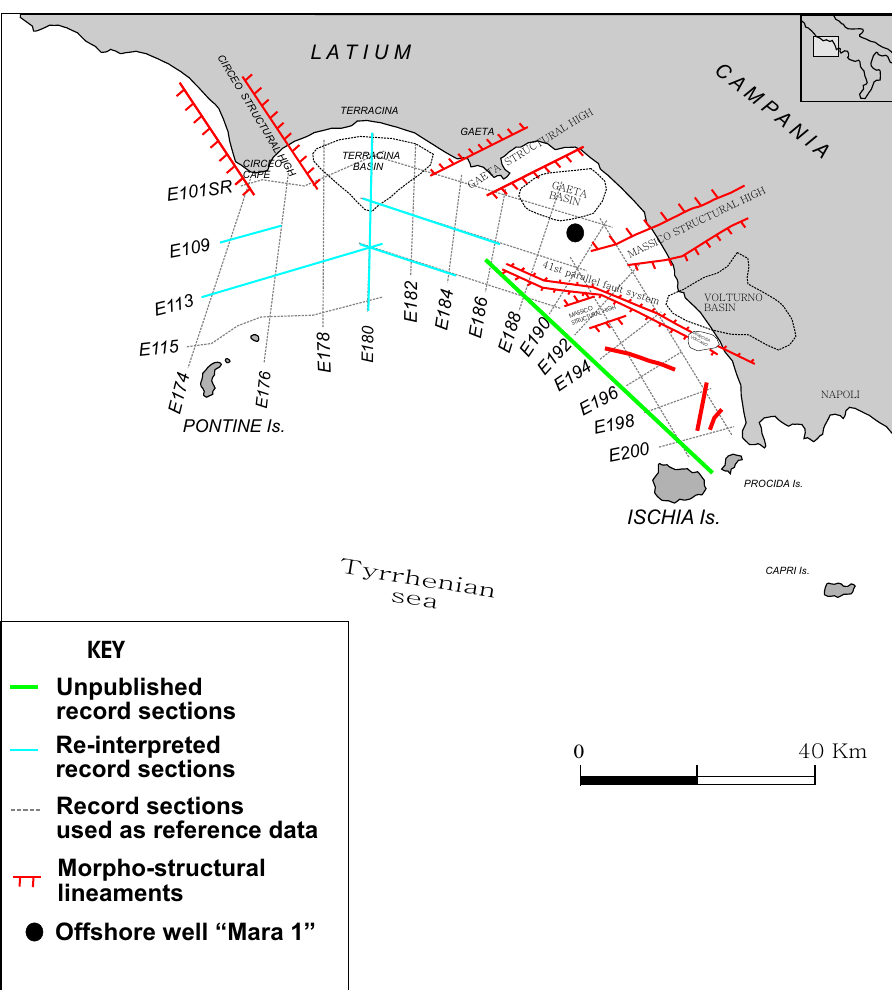
Figure 1. Map of the interpreted seismic sections. Unpublished record sections, re-interpreted record sections and record sections used as reference data are indicated. The regional morpho-structures on the Northern Campania Tyrrhenian continental margin detected through reflection seismic profiles are also shown [after Bartole 1984, Bruno et al. 2000, Aiello et al. 2000, de Alteriis et al.